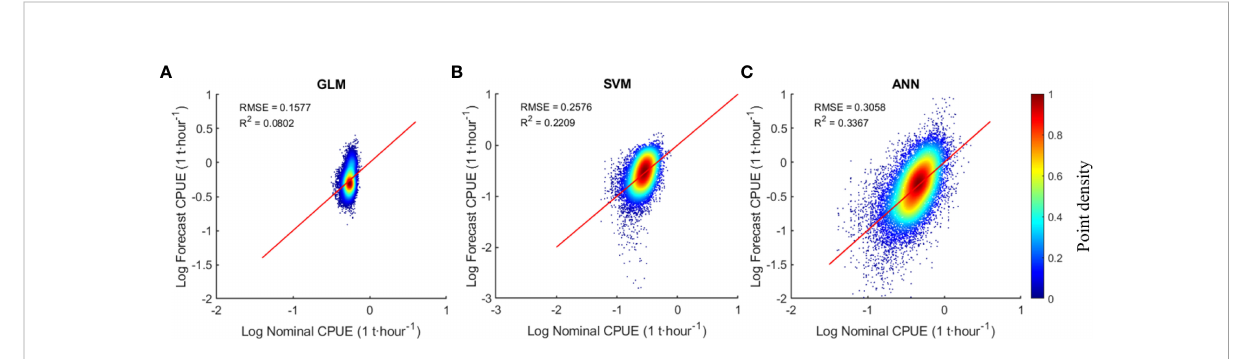
FIGURE 5 Comparison of regression analysis results of three models, (A – C) are GLM, SVM, ANN models